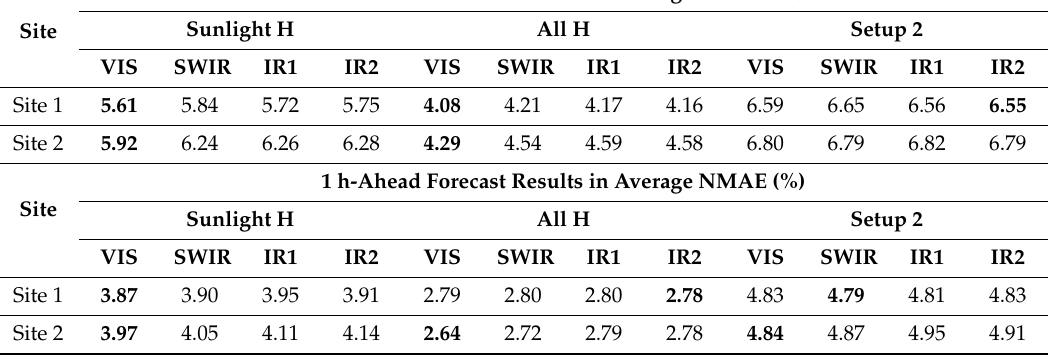
Table 12. Average NMAE results of individual spectral bands for 2 h- and 1 h-ahead forecasts via the DNN model in both setups (bold text indicates the lowest average NMAE values among the four spectral